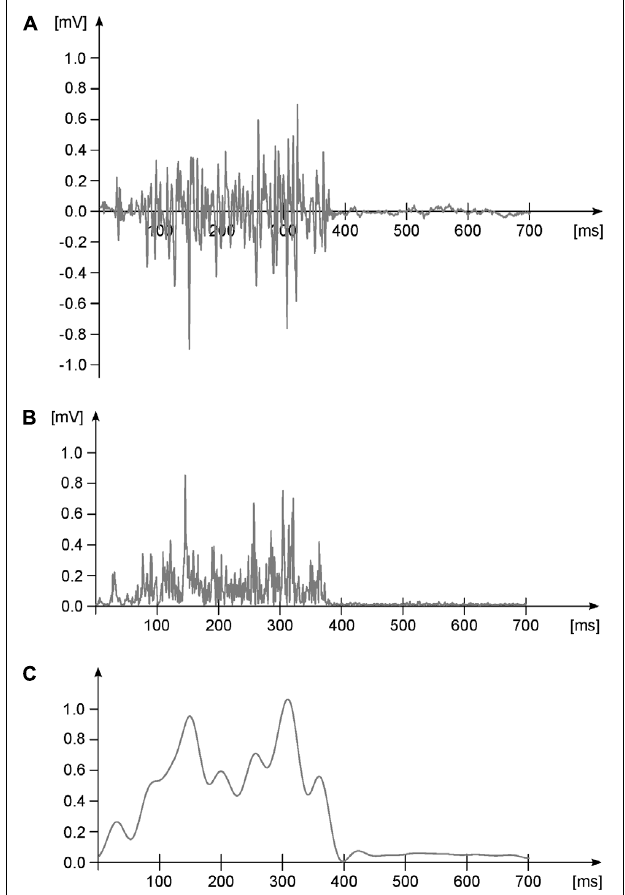
FIGURE 1 | Exemplary EMG activity of one muscle during one gait cycle. (A) Raw data. (B) Raw data after high-pass filtering (4th order IIR Butterworth zero-phase filter, cut-off frequency 50 Hz) and full-wave rectification. Panel (C) rectified and high-pass filtered data after low-pass filtering (4th order IIR Butterworth zero-phase filter, cut-off frequency 20 Hz) and normalization to the maximum (dimensionless y -axis units). This last step is done for creating the linear envelope of the